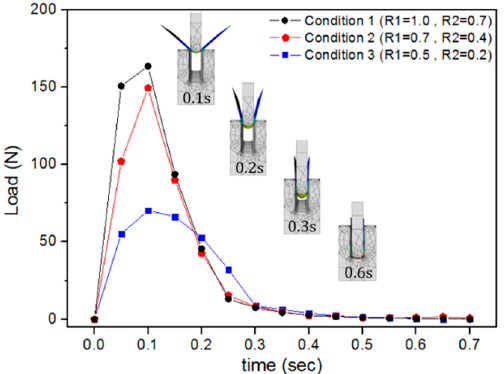
Figure 8. The comparison of forming load according to R1 of the die and R2 of the punch.